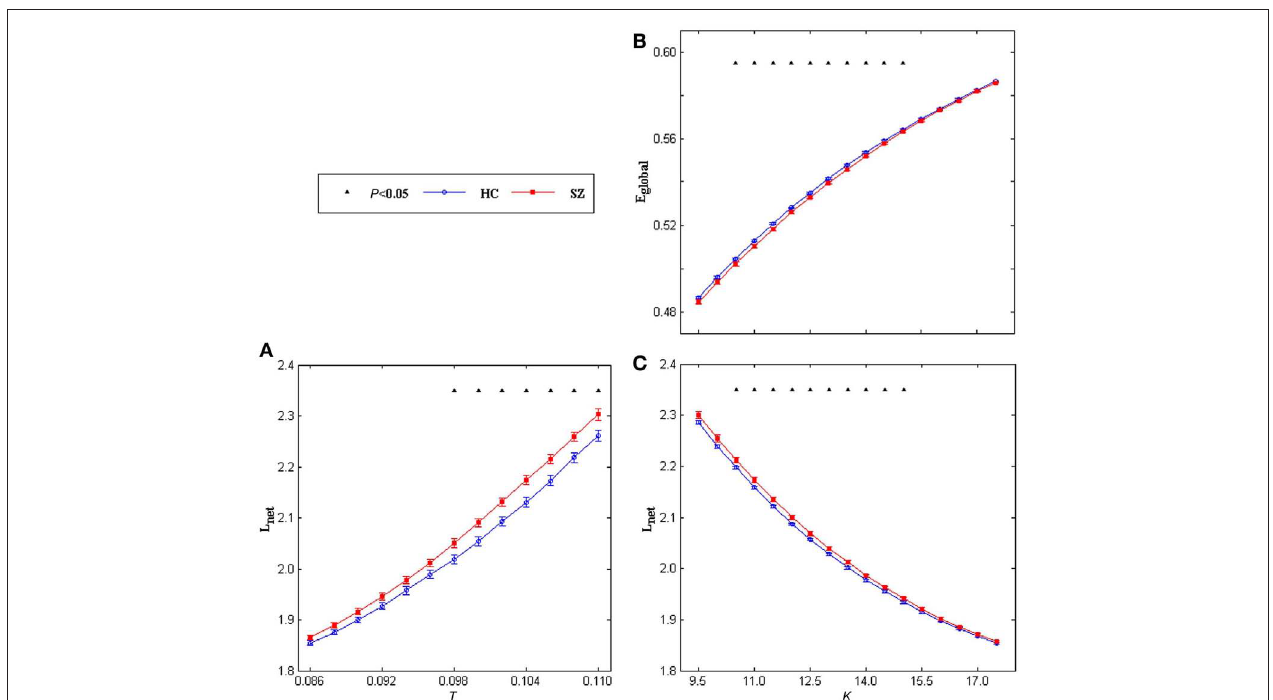
FIguRe 2 | Mean absolute z -score matrices for HCs and SZ. Each figure shows a 95 × 95 square matrix, where each entry indicates the mean strength of the connectivity between each pair of voxels. For comparison, z values corresponding to P = 0.05 are 0.0975 (uncorrected) and 0.118 (FDR corrected).